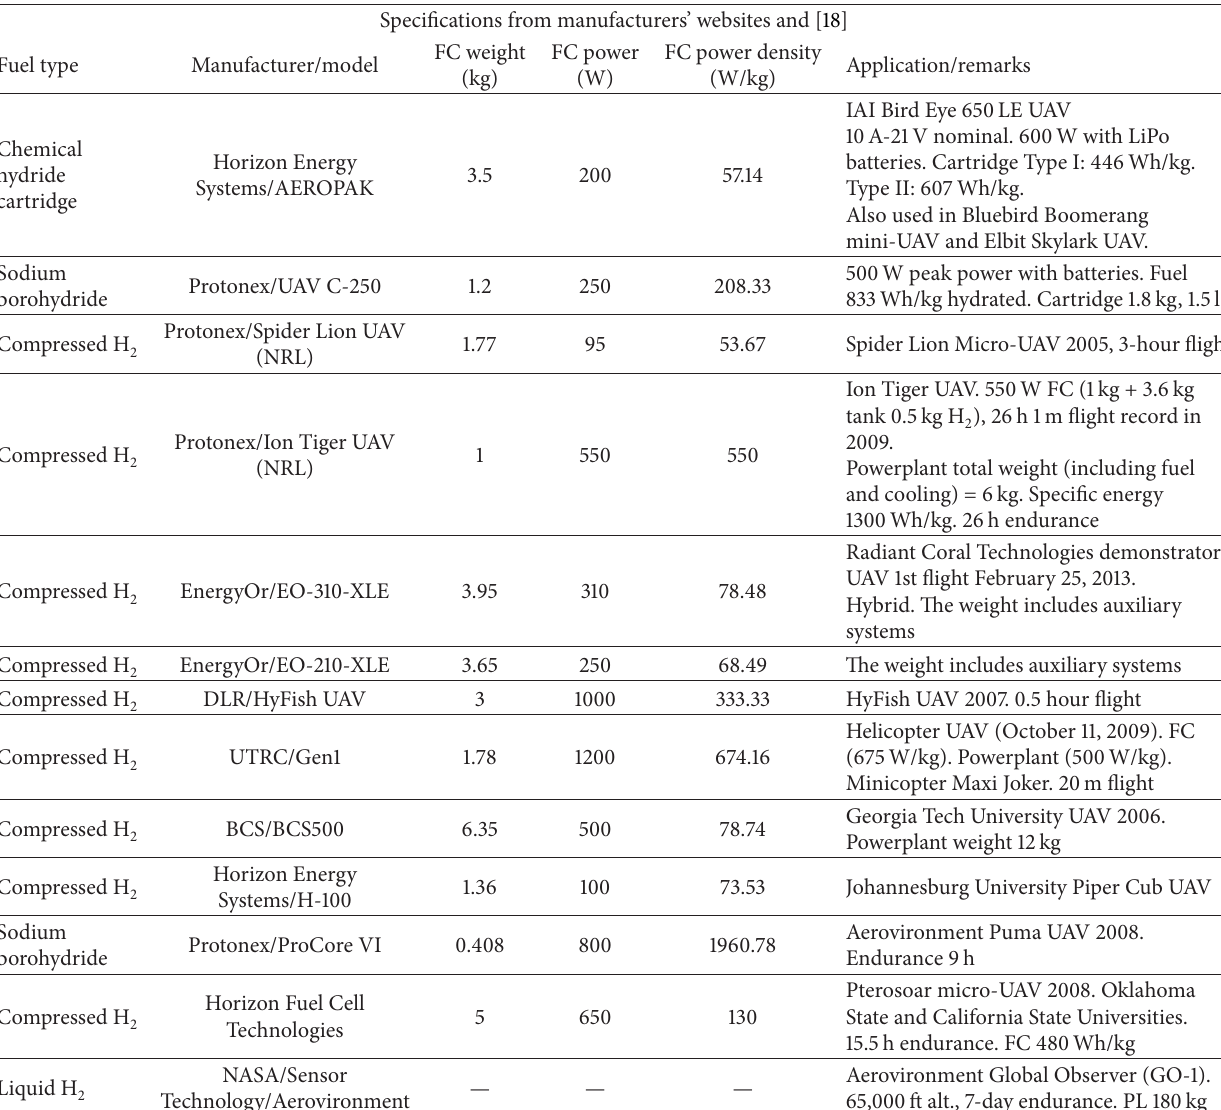
Table 2: Examples of PEM fuel cells for UAV